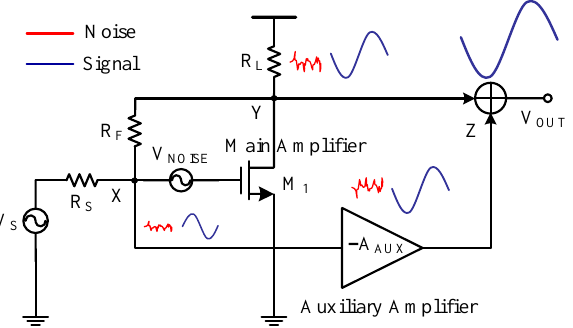
Figure 5. Block diagram of the feedforward noise-canceling technique [13].